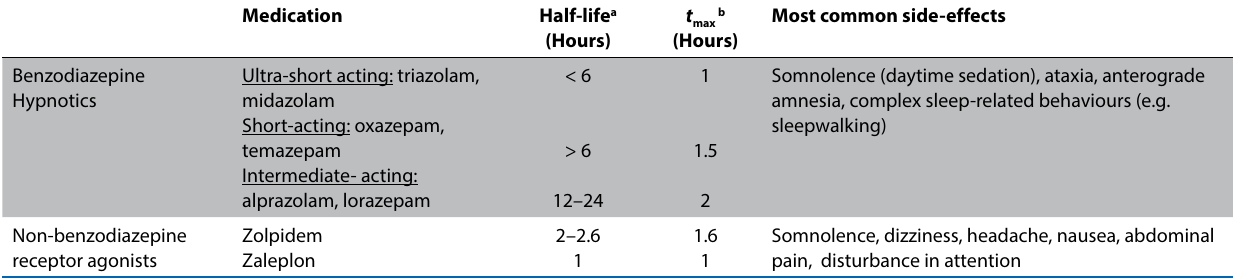
Table 4: Pharmacokinetics and side-effects of Benzodiazepine receptor agonists used for Insomnia disorder